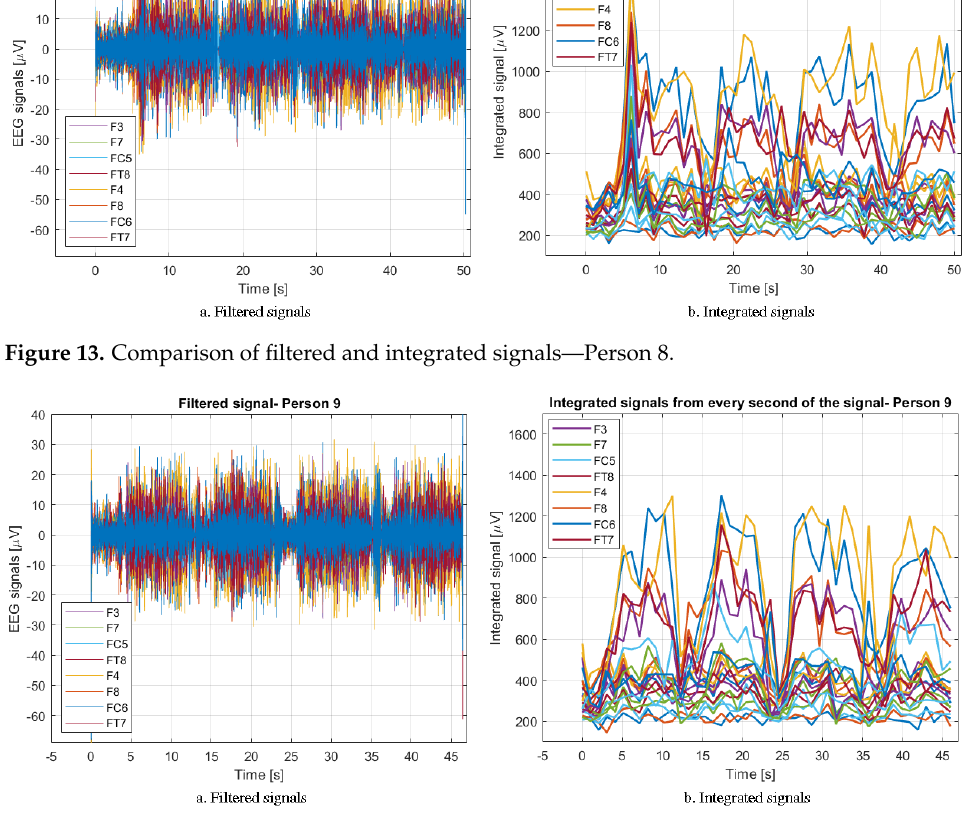
Figure 14. Comparison of filtered and integrated signals—Person